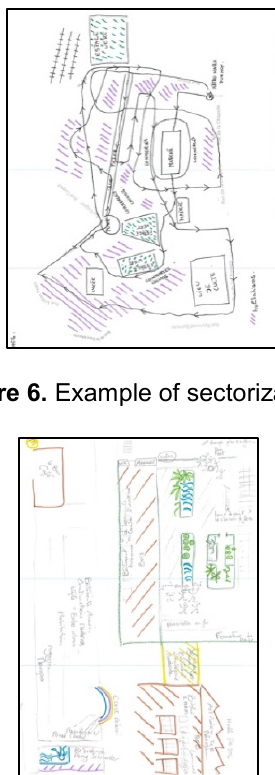
Figure 7. Example of sectorizations